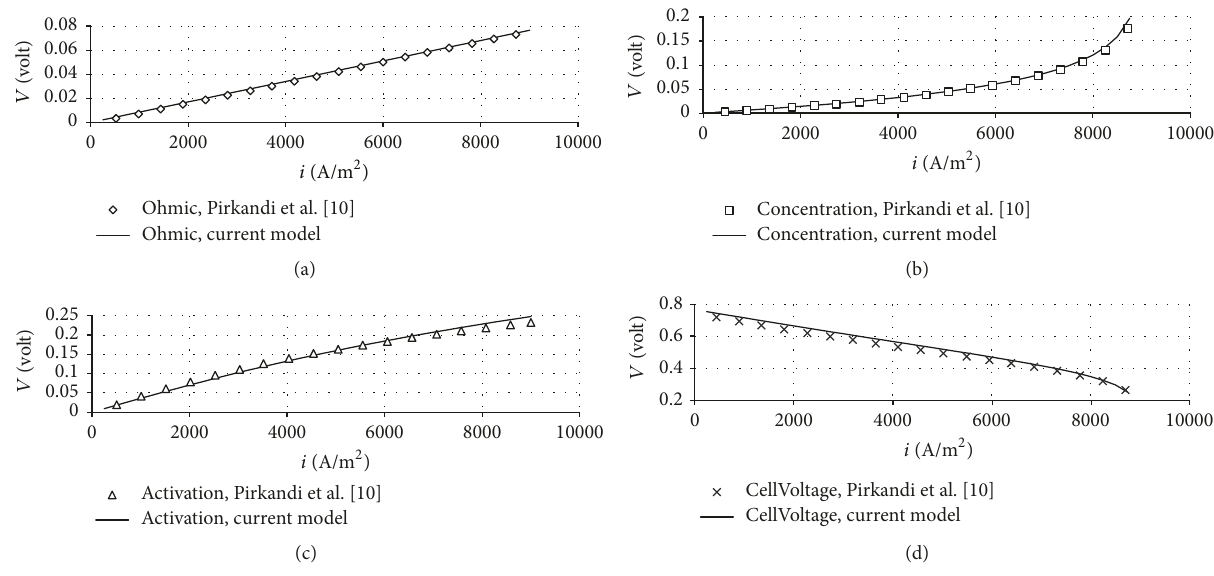
Figure 2: IRSOFC validation: (a) ohmic overpotential, (b) concentration overpotential, (c) activation overpotential, and (d) cell voltage.